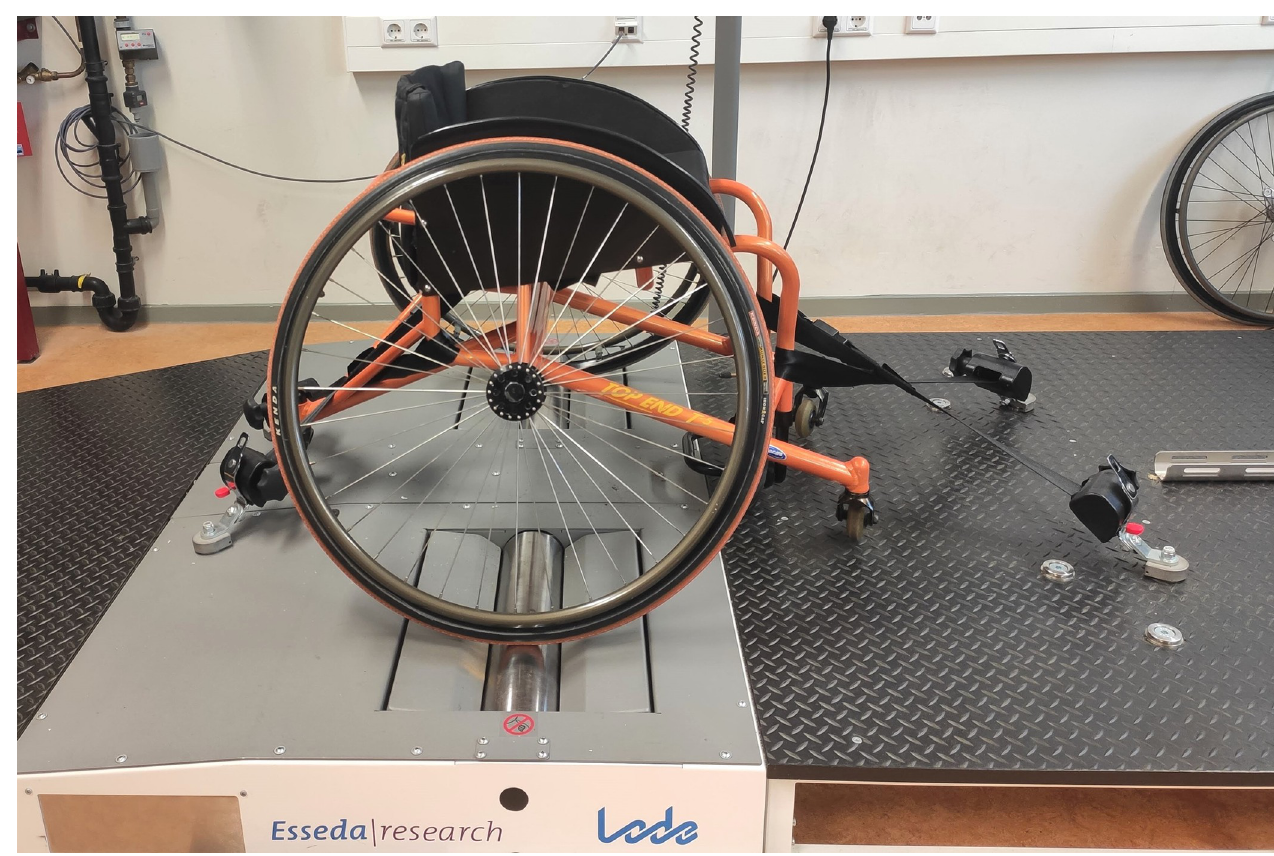
Fig 1. The Esseda wheelchair roller ergometer with the wheelchair used in